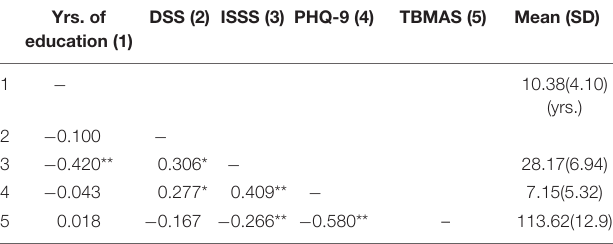
TABLE 2 | Correlations and descriptive study of study